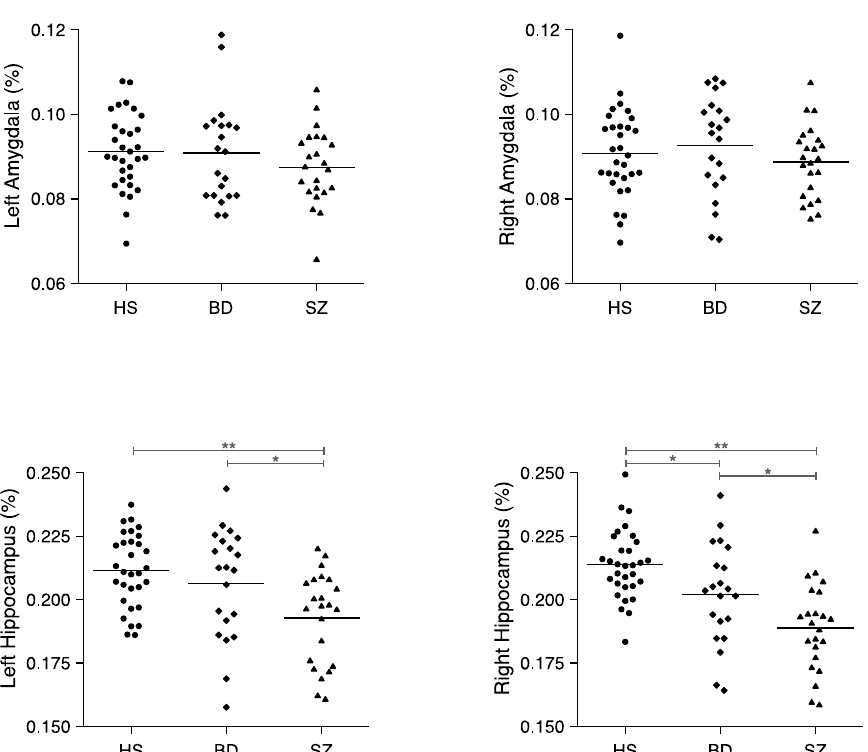
Figure 2. Relative volumes of the left and right amygdalae and hippocampi in healthy subjects (HS) ( n = 31), patients with bipolar disorder (BD) ( n = 21), and patients with schizophrenia (SZ) ( n = 23). Horizontal lines indicate means. * p < 0.05, ** p < 0.001.